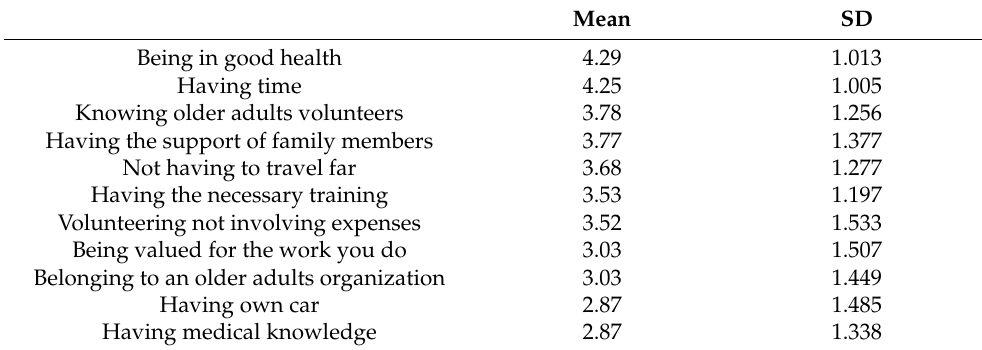
Table 3. Factors that facilitate volunteering. Scale from 0 to 5 (0 = not at all and 5 = a